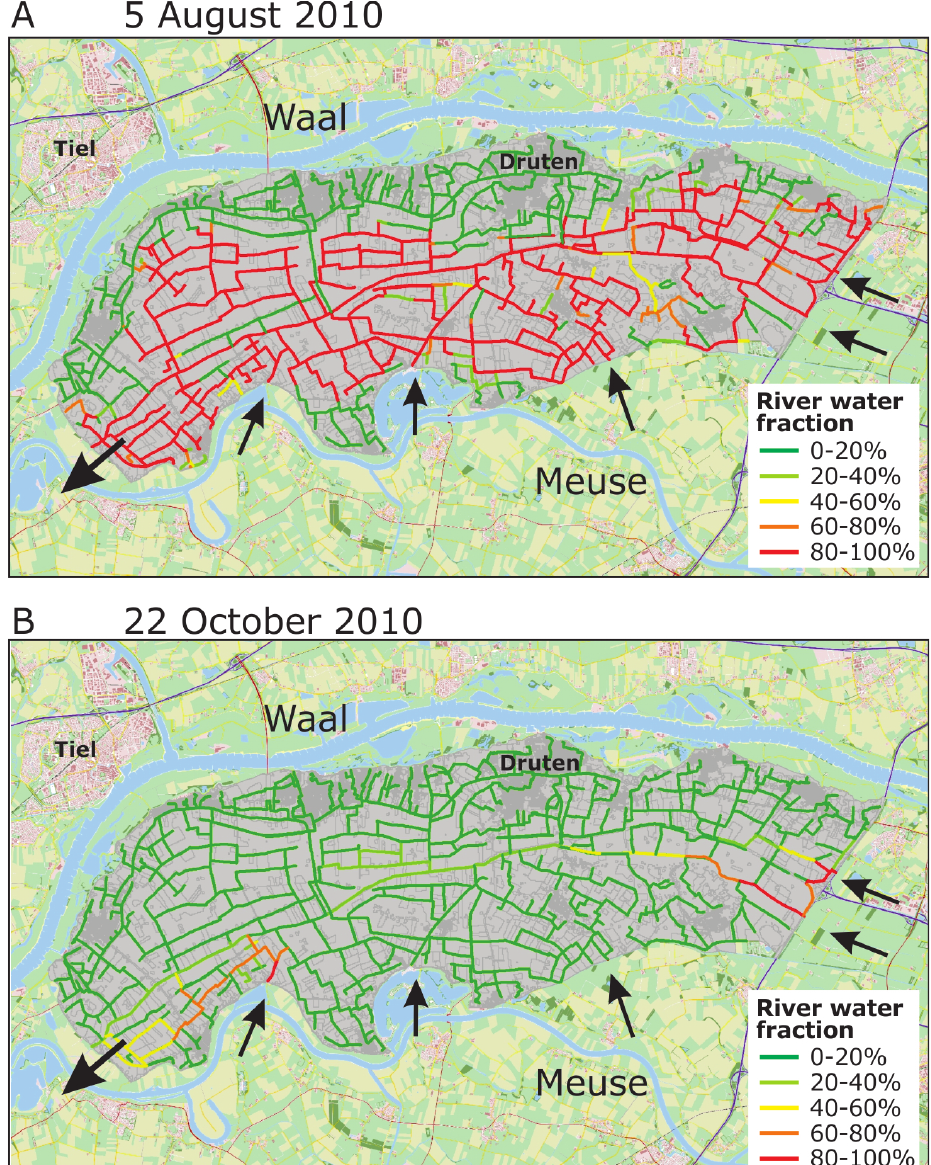
Fig. 4. Modeled proportions of diverted river water in the main ditches and channels on 5 August and 22 October 2010.